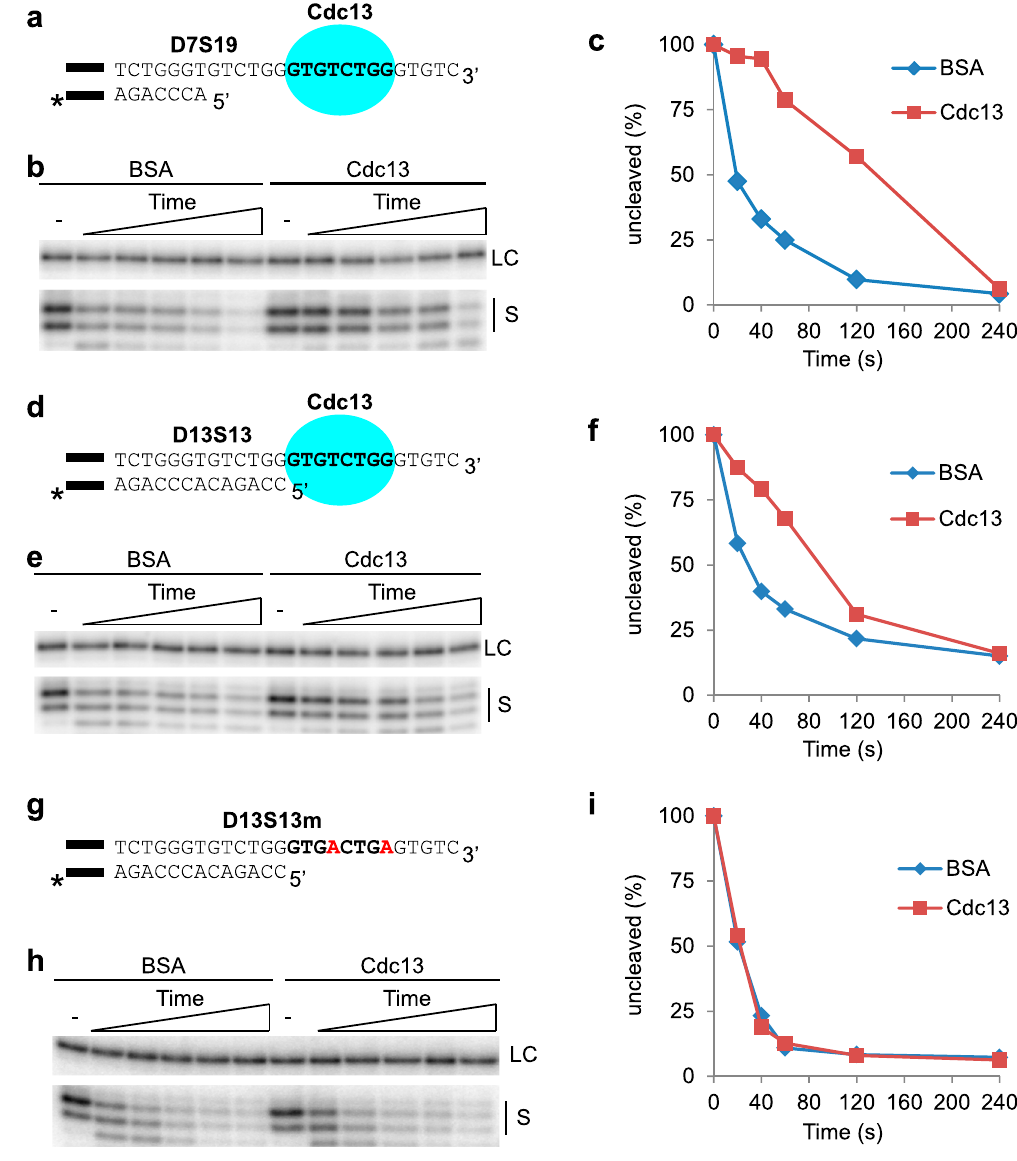
Figure 3. Cdc13 protects the 5 ′ end when positioned both further away and closer to the ds-ss junction, but not when unable to bind the 3 ′ overhang. ( a,d,g ) The substrates used for DEPA experiments. The black bar indicates the guide sequence, and “ * ” the radioactive label (as described in Fig. 2 legend). ( a ) D7S19 contains 7 bp of telomere dsDNA and a 19 nt ssDNA telomere 3 ′ overhang. The Cdc13 MBS (bold text) is located 6 nt from the ds-ss junction. ( d ) D13S13 telomeric part contains 13 bp dsDNA and a 13 nt 3 ′ overhang. The Cdc13 MBS (bold text) is located adjacent to the ds-ss junction. ( g ) D13S13m contains 13 bp of telomere dsDNA and a 13 nt 3 ′ overhang with mutations in the Cdc13 MBS (shown in red). ( b,e,h ) Sequencing gels of the DEPAs using D7S19 ( b ), D13S13 ( e ) and D13S13m ( h ). The loading control (LC) and uncleaved substrate (S) from the Cdc13 containing and BSA control reactions at 0; 20; 40; 60; 120; 240 s are indicated. ( c,f,i ) Quantification of the DEPA gels shown in ( b ), ( e ) and ( h ) respectively. Quantifications were made as described in Fig. 2 and in material and methods section. Full-size gels showing all reaction products are shown in Supplementary Fig.